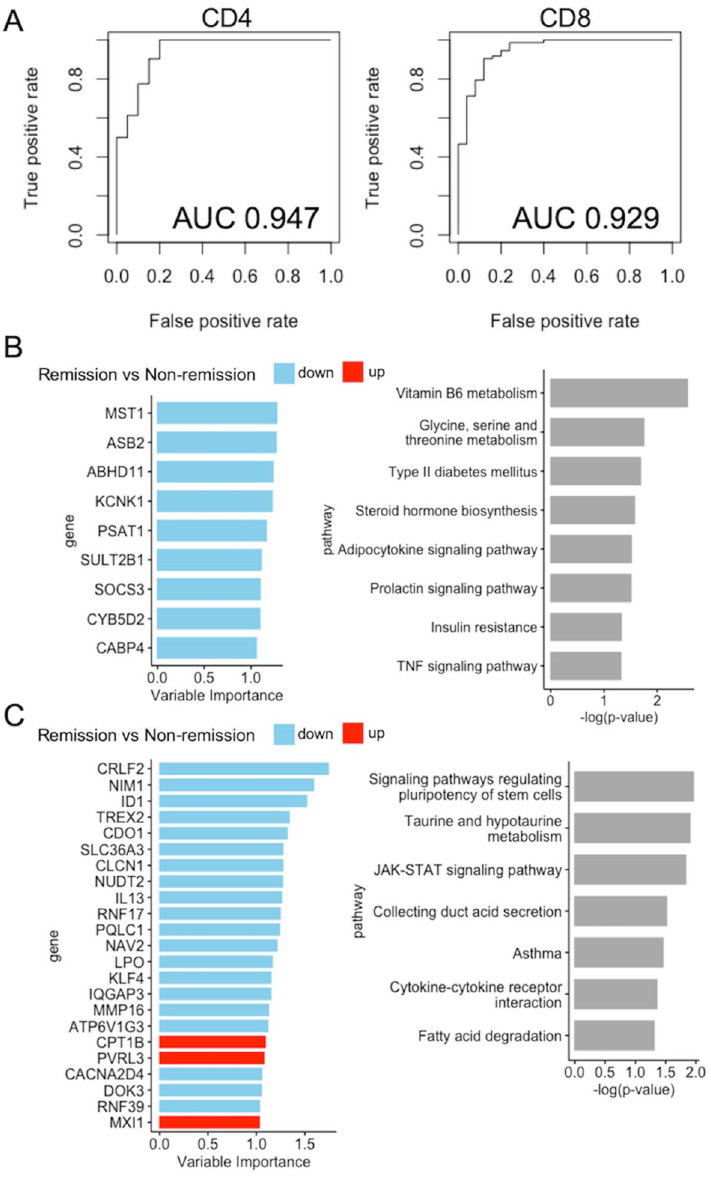
gene expression, with blue indicating low and red toward high expression in remission patients. AUC, area under the curve; PLS-R, a partial least-squares regression; RA, rheumatoid arthritis; ROC, receiver operating